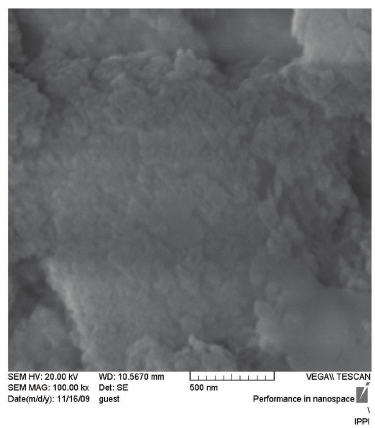
Figure 1: SEM picture of synthesized bioglass-ceramic and chitosan